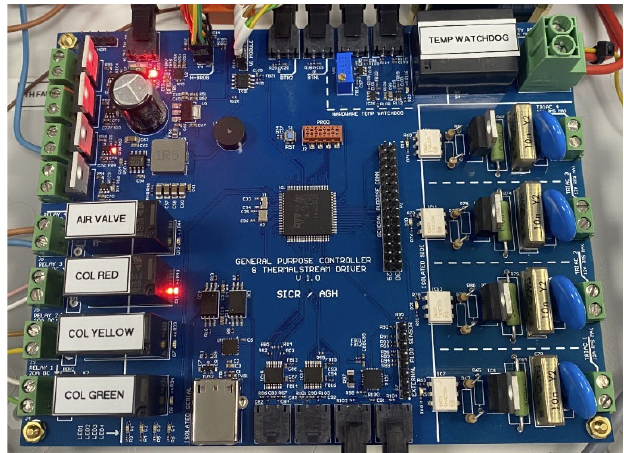
Figure 9. Main board of the unit.